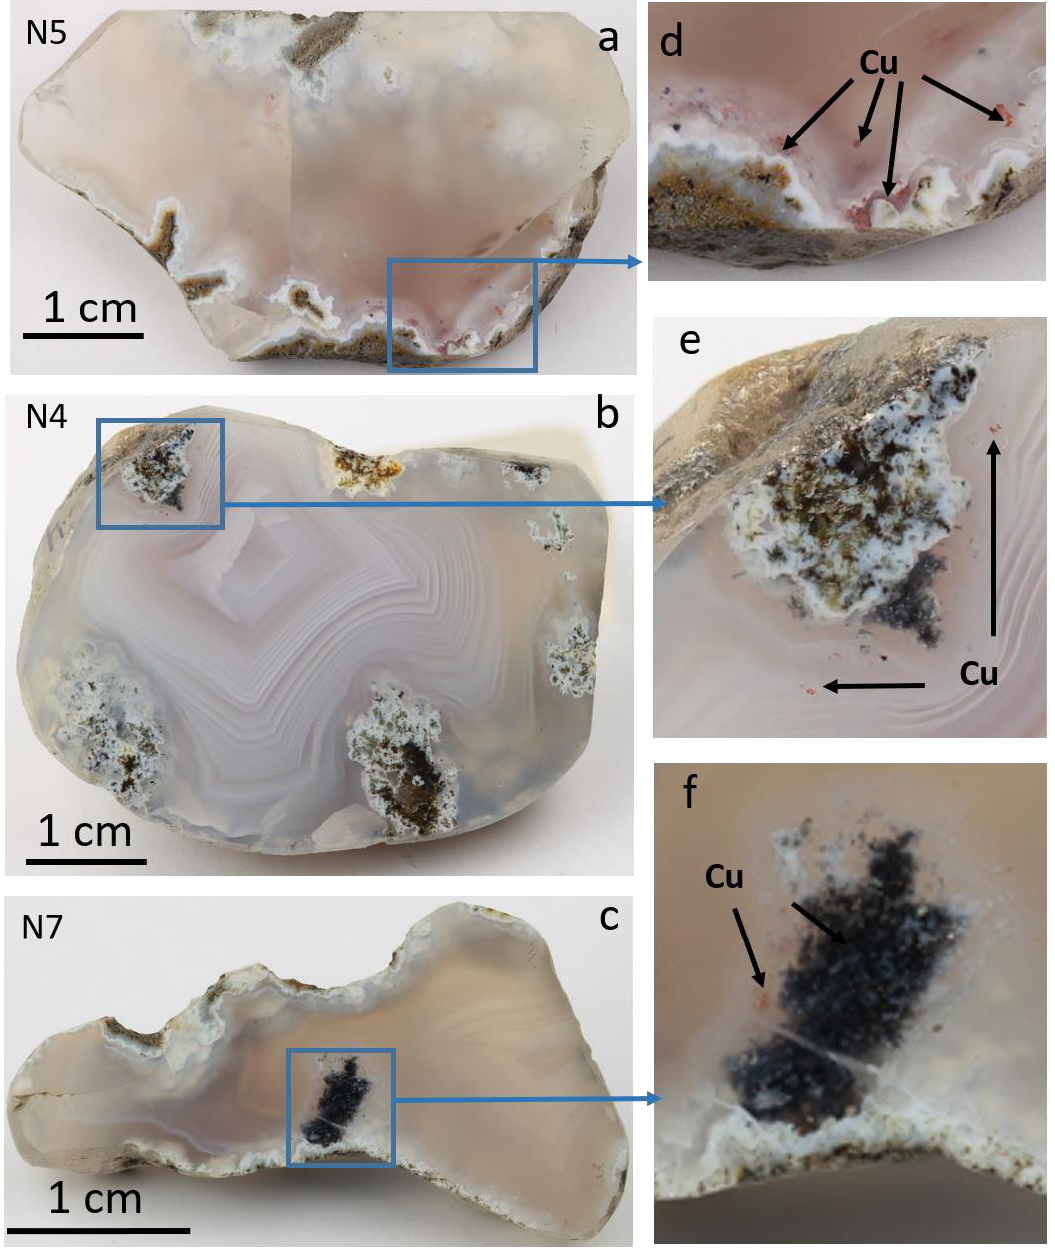
Figure 4. Macrophotographs of studied agates ( a – c ) and enlarged fragments ( d – f ) with microinclusions of native copper (red) and other minerals. The Avacha Bay (East Kamchatka, Russia). Polish sections of agates. Photos by A. Vishnevskii.